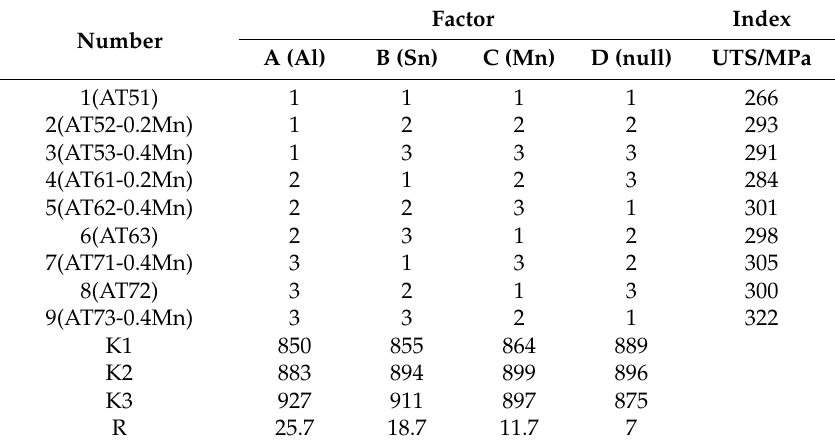
Table 4. Orthogonal test parameters and results analysis table under the ultimate tensile strength (UTS) index.